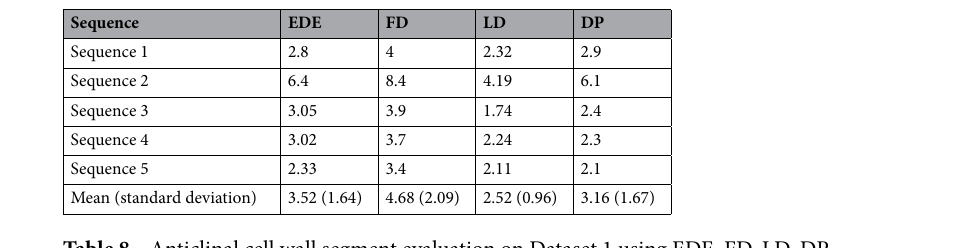
Table 8. Anticlinal cell wall segment evaluation on Dataset 1 using EDE, FD, LD, DP.